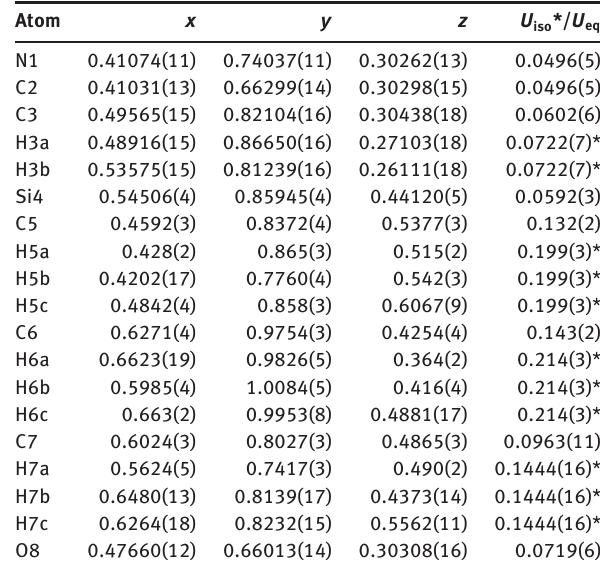
Table 2: Fractional atomic coordinates and isotropic or equivalent isotropic displacement parameters (Å 2